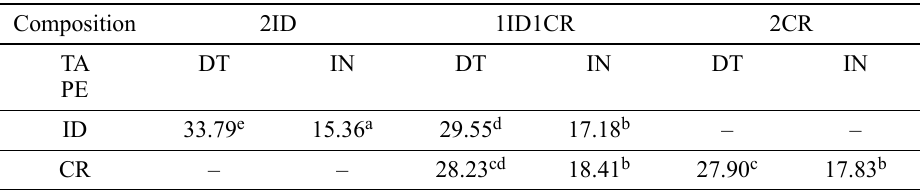
Table 4. Mean comparisons as a function of dyad composition, personality and tactic